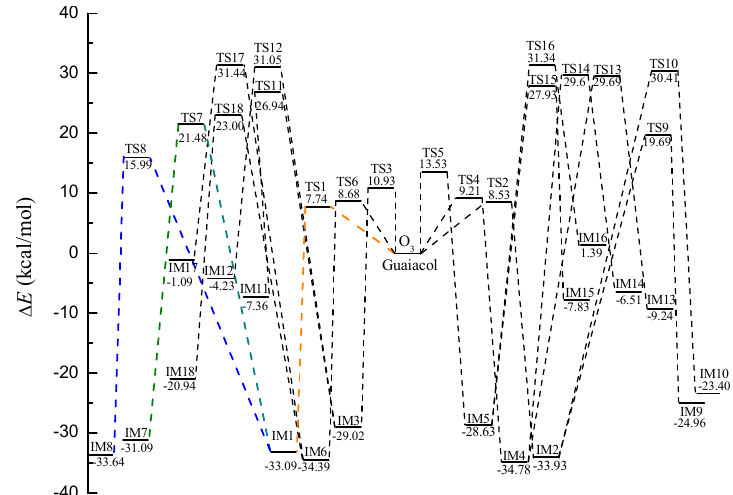
Figure 4. Profiles of the energy surface for the initial reaction of guaiacol with ozone, and the followed self-decomposition.